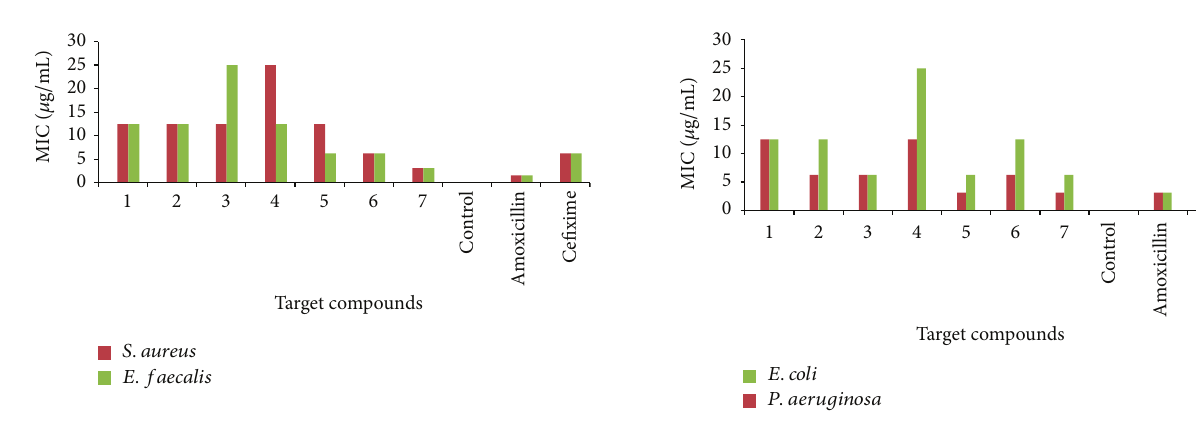
Figure 2: Graphical representation of minimum inhibitory con- centration (MIC) of benzamide substituted Mannich bases against Gram positive bacterial strains.